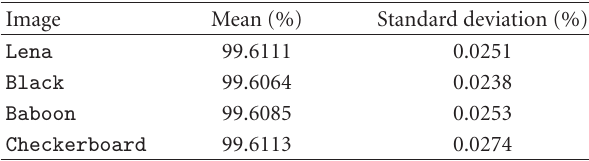
Table 2: Number of pixel change rate (NPCR) between images encrypted with keys K 1 and K 2 (with 1 bit di ff